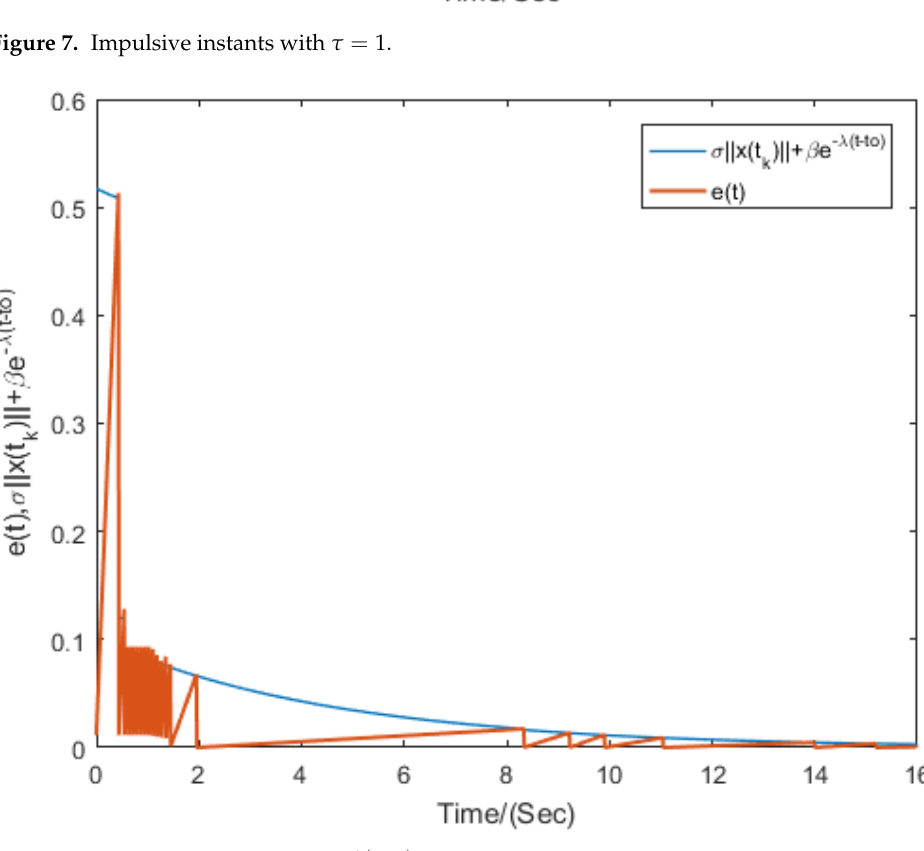
Figure 8. (cid:107) e ( t ) (cid:107) and σ (cid:107) x ( t k ) (cid:107) + β e − λ ( t − t 0 ) with τ =